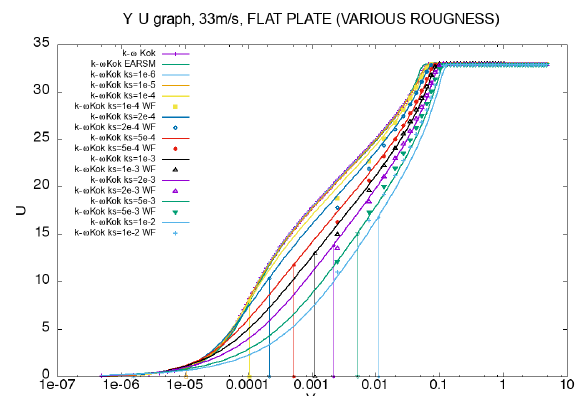
Fig. 2. CFD simulations, standard wall function over rough sur- faces, height of the first cell 0.001m, regime U ∞ = 33 m.s − 1 . Graph for the U , k ,ω in the vertical cut at x = 5m (comparison with expected data).